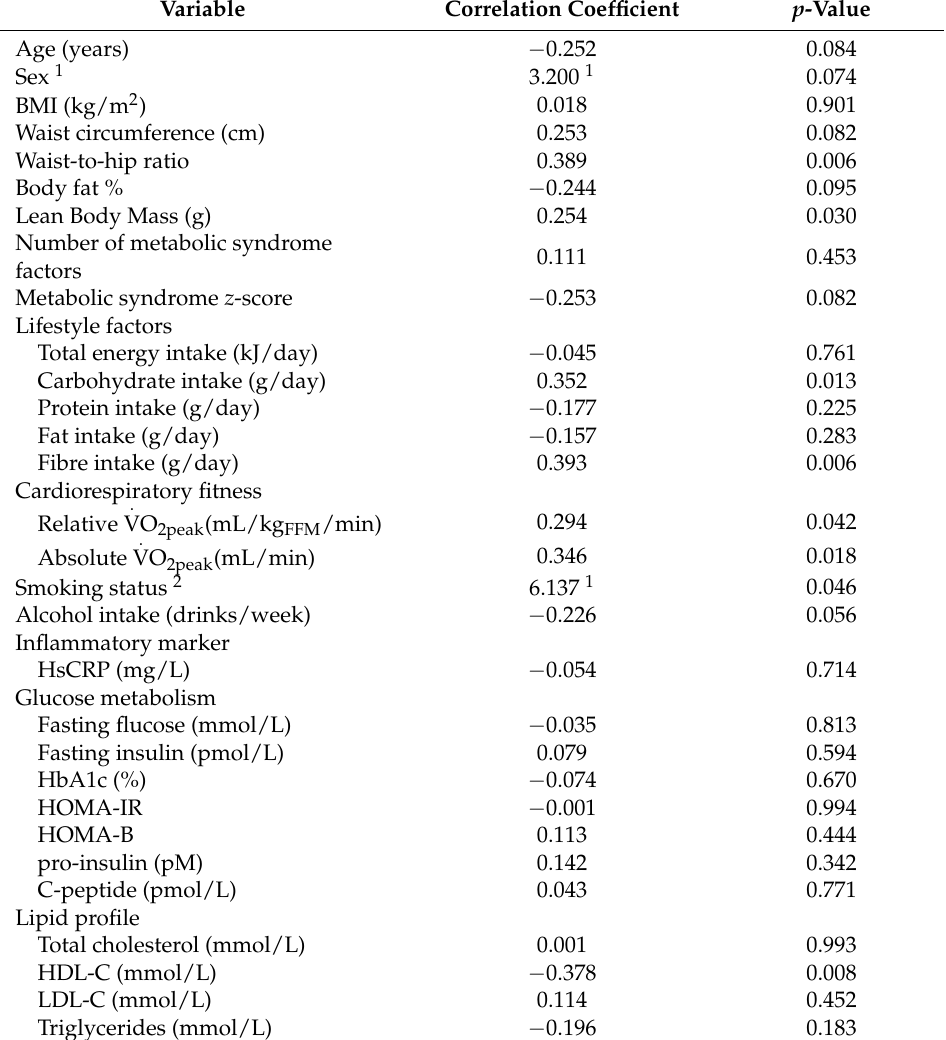
Table 2. Bivariate correlations between IL-22 and demographic, lifestyle, and clinical measures in participants diagnosed with metabolic